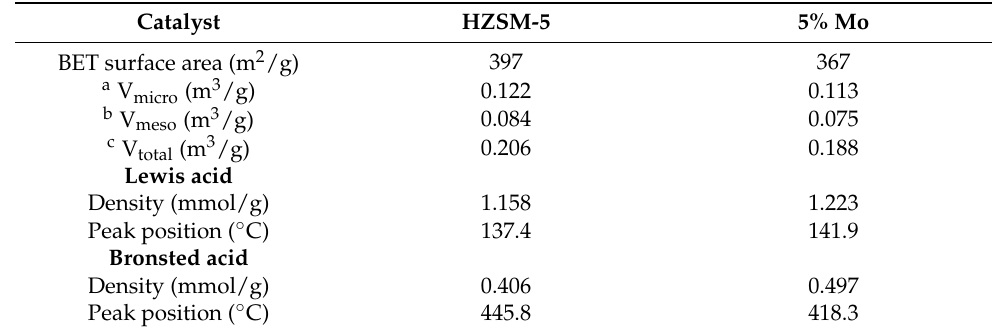
Table 1. Summary of texture properties and acidity of fresh